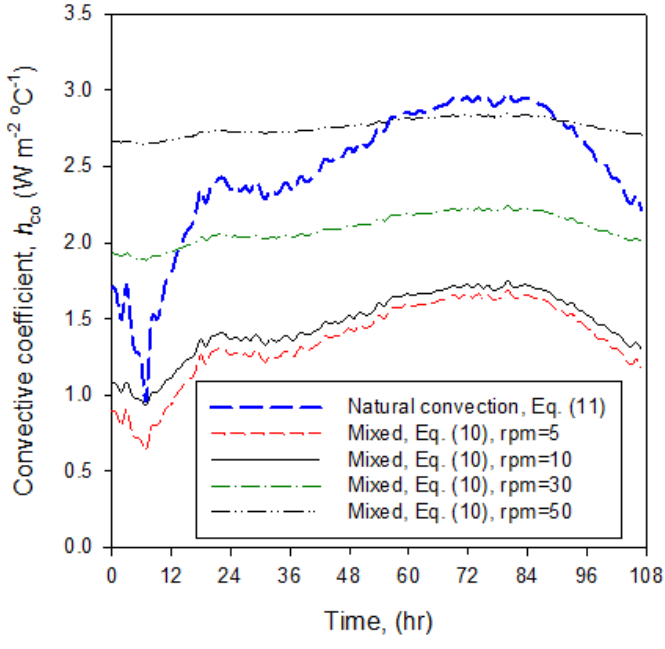
Figure 4. Convective heat transfer coefficient at the outer surface of the reactor cylinder, h co (W · m − 2 · ◦ C − 1 ) estimated for the mixed convection (Equation (10)) and natural convection (Equation (11)) mechanisms. Table 1. Parameters used in the calculation of energy terms.